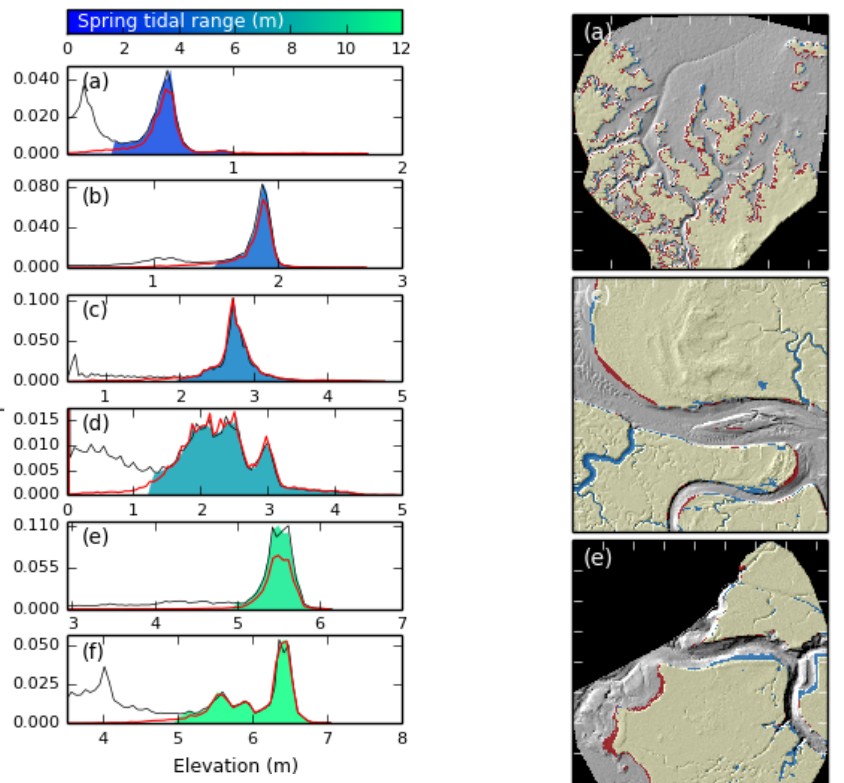
Figure 9. Elevation distribution functions for sites S1 to S6 (panels (a) to (f) , respectively). The red line corresponds to the elevation distribution for the reference rasters. The filled area corresponds to the elevation distribution of the automatically processed rasters, coloured according to their spring tidal range. The grey line repre- sents the elevation distribution of the original DEM, with frequency maxima set to match those of the automatically processed rasters so as to nullify the effect of empty cells.